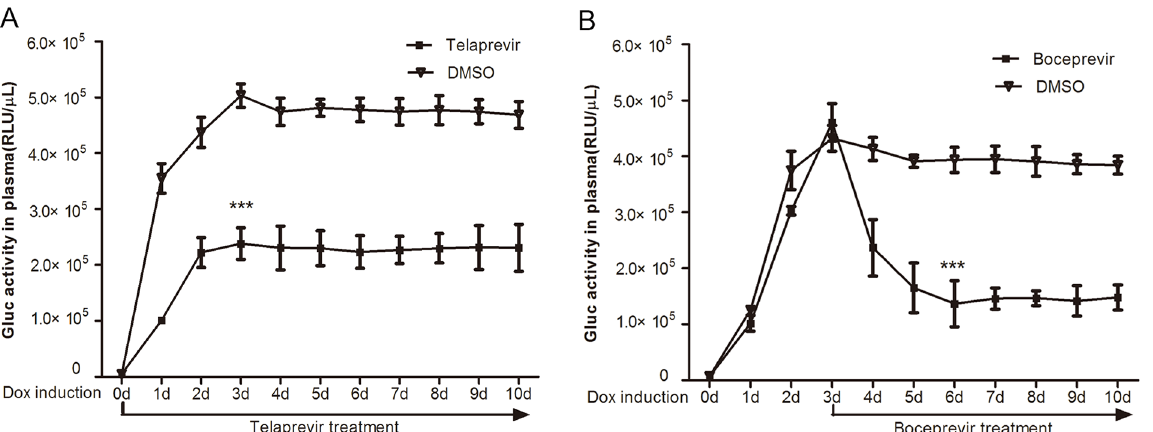
Fig 5. Utilizing the triple-transgenic mouse model to evaluate the effects of NS3/4A protease inhibitors. (A) Two groups of triple-transgenic mice (n = 5 per group) were treated with telaprevir (200 mg/kg) or DMSO via oral gavage twice daily for 10 days. During the treatment period, the mice were continuously induced with Dox (1 mg/mL Dox and 50 g/L sugar were dissolved in their drinking water). (B) Triple-transgenic mice were induced with Dox for 10 days (n = 5 per group). At the third day after Dox induction, the mice were treated with boceprevir (100 mg/kg) or DMSO via oral gavage twice daily for 7 days. Blood samples were collected daily from the caudal vein to measure plasma Gluc activity. Each data point represents the mean ± SD. *** = p < 0.001 compared with the vehicle control.